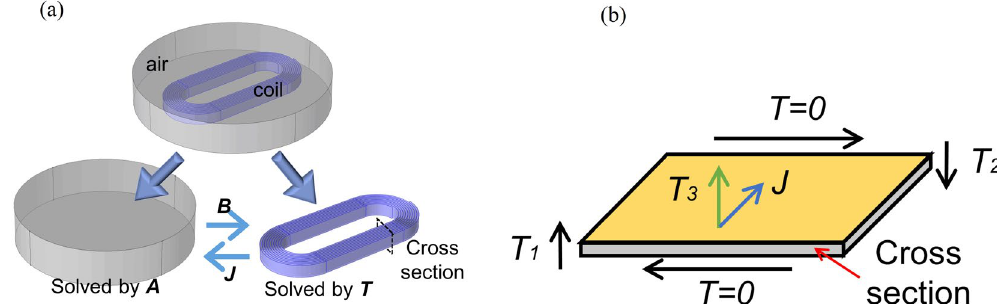
Figure 1. Solving process by the T–A formulation. ( a ) A 3D model includes air and sheet-like HTS domains. The domains are exchanged by current density J and magnetic flux density B with the two variables being solved separately. ( b ) A single turn of an HTS wire with current vector potential T actually normal to its surface. Two boundaries of the cross section are set by T 1 and T 2 (i.e., the components of T